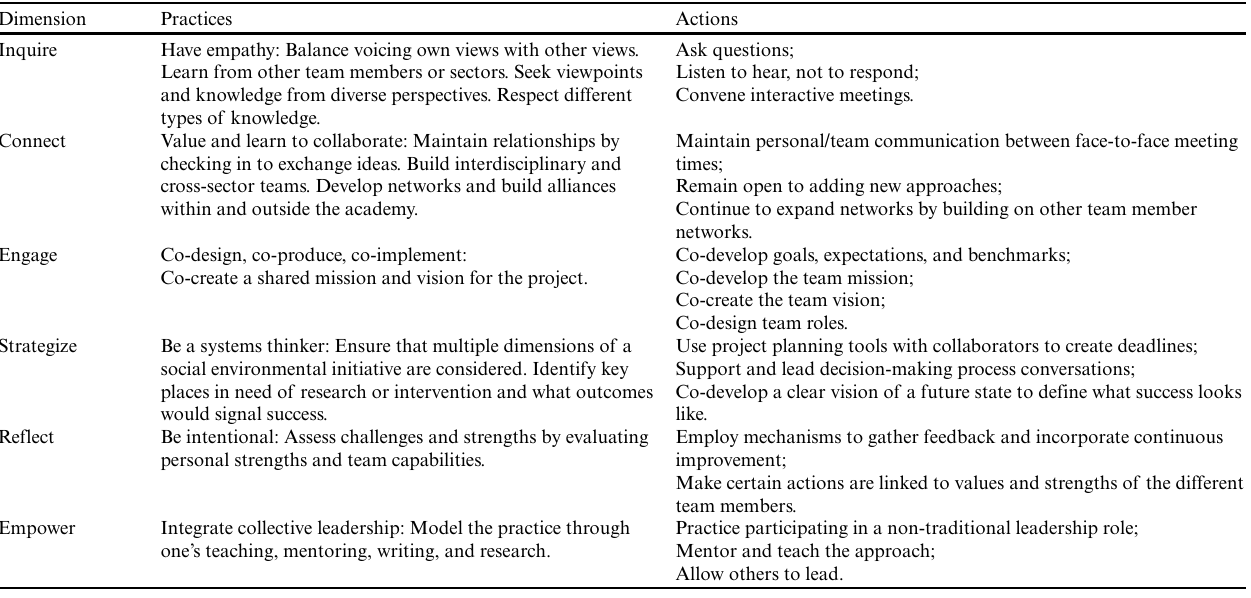
Table 2. Practicing collective